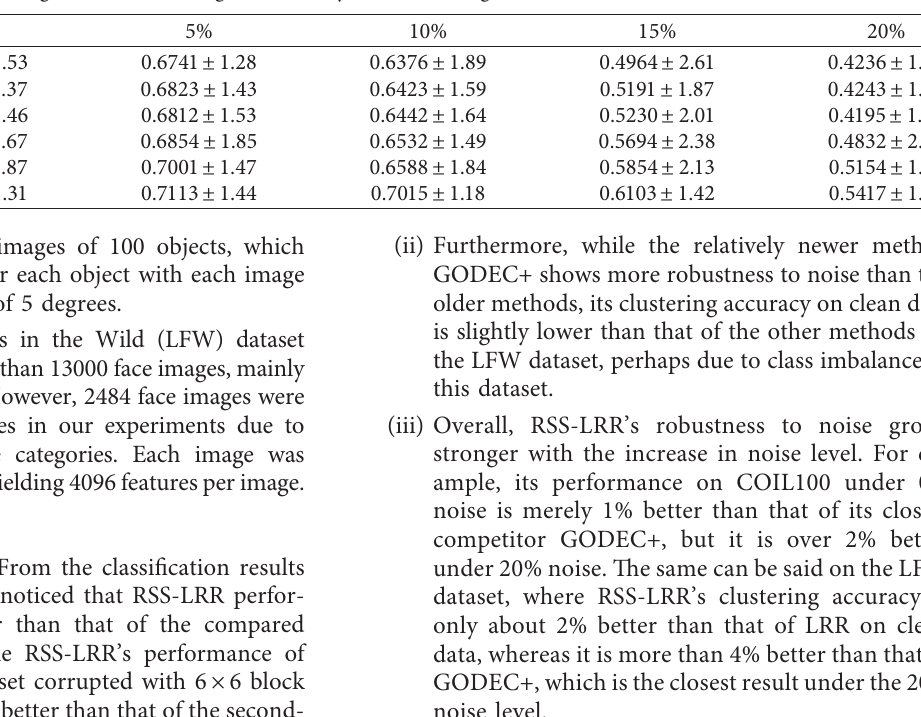
Table 10: Clustering results concerning the accuracy of different algorithms on the COIL100